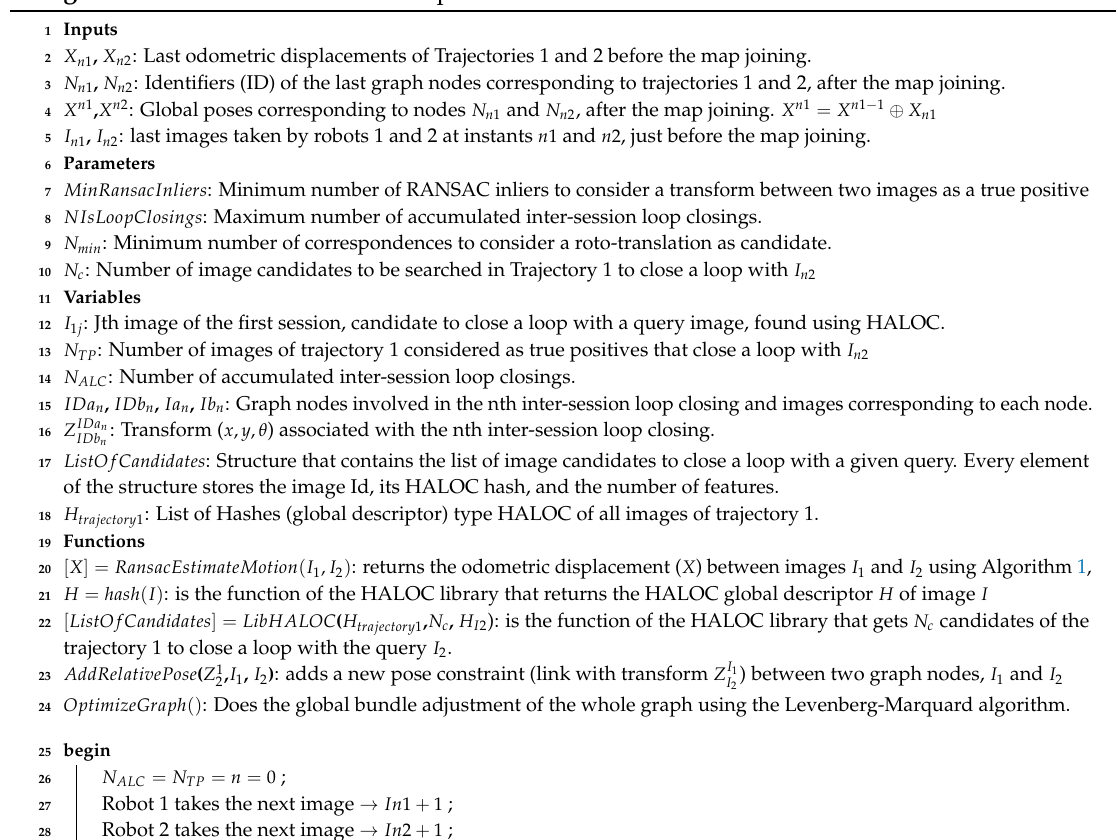
Algorithm 2: Multi-robot Visual Graph